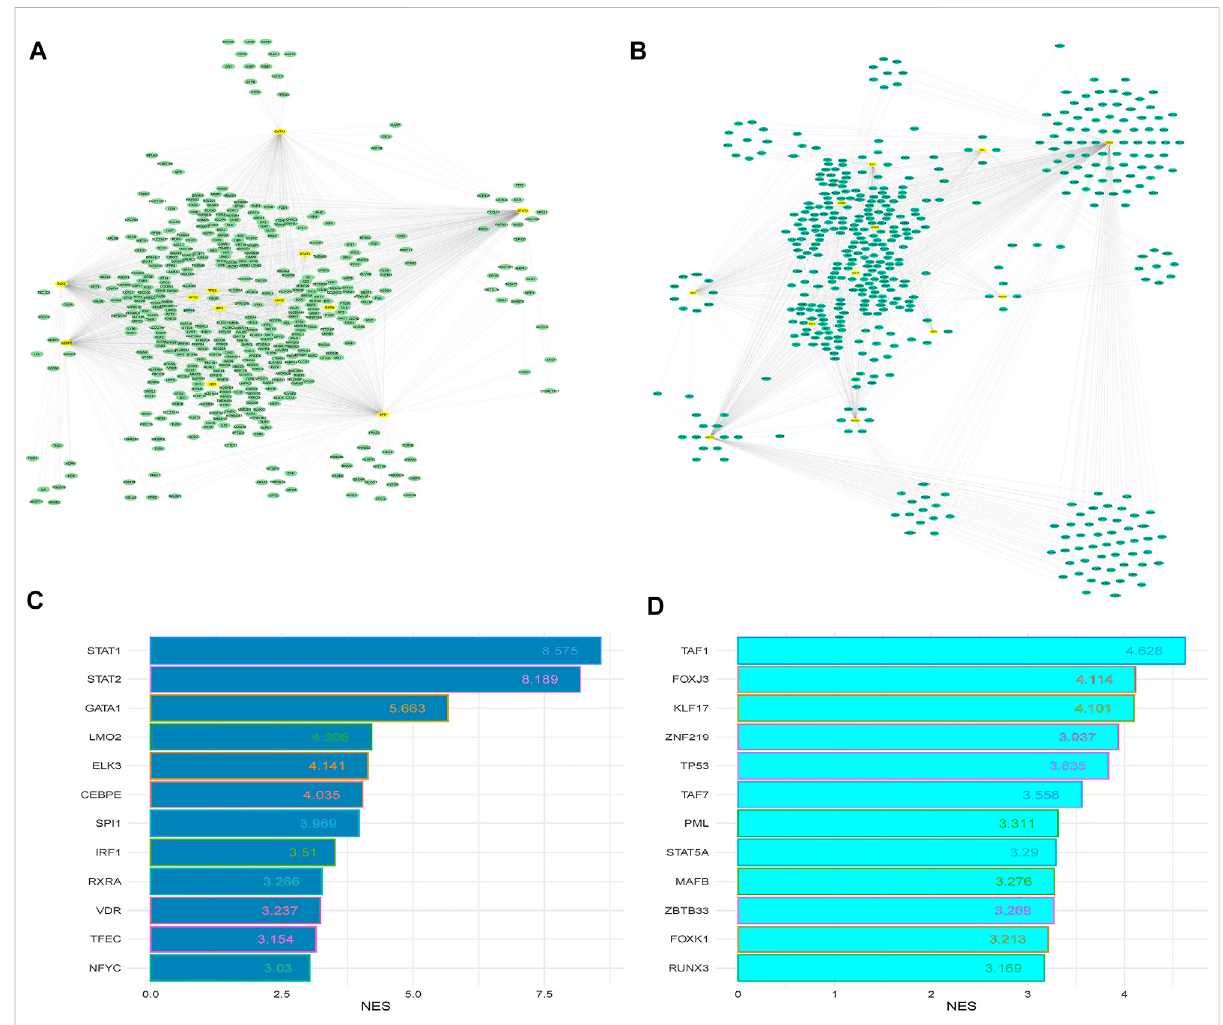
FIGURE 4 Themastertranscriptionalregulators(MTRs)regulatorynetworksandtheirtargetedup-regulatedanddown-regulatedDEGsbetweenPAHand control. (A) RegulatorynetworkoftheMTRsandtheirtargetedup-regulatedgenesinthePAHgrouprelativetothecontrol. (B) Regulatorynetworkof the MTRs and their targeted down-regulated genes in the PAH group relative to the control. (C) The MTRs regulate the up-regulated genes with NES > 3.0. (D) The MTRs regulate the downregulated genes with NES > 3.0. The yellow nodes indicate signi fi cantly enriched MTRs, and the other color oval indicates identi fi ed